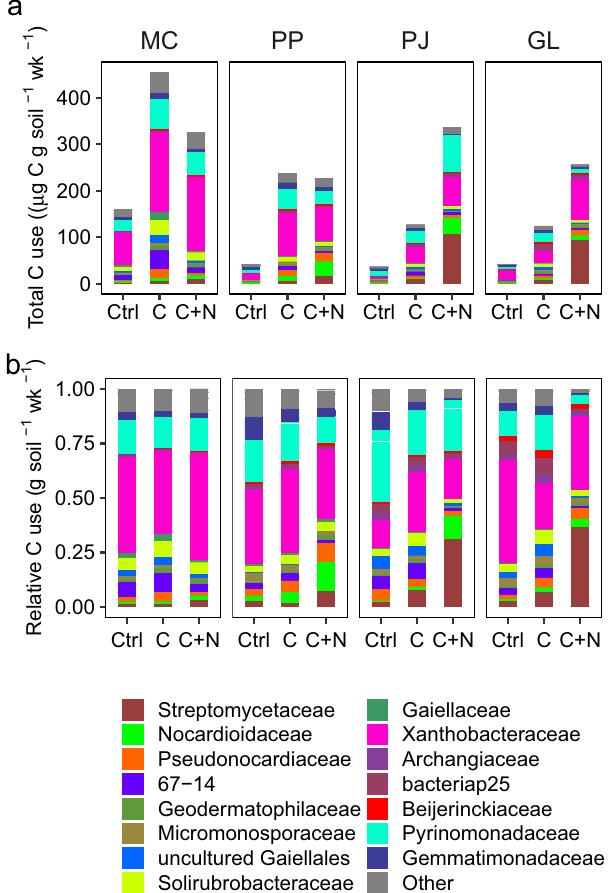
Fig. 2 Absolute and relative carbon (C) use of bacterial families, per gram of dry soil per week (wk). Values averaged across replicates for each ecosystem (MC mixed conifer forest, PP ponderosa pine forest, PJ piñon pine-juniper scrubland, GL desert grassland) by treatment (rows: Ctrl = no amendment, C = glucose only, C + N = glucose and [NH 4 ] 2 SO 4 ) combination ( n = 3 experimental replicates). Bar color represents bacterial family (15 shown, accounting for ≥ 75% of C use, remaining families designated as “ Other ” ). a Total C use (C-CO 2 respired and MBC produced) from each bacterial family. b C use for each bacterial family, relativized by total C use.